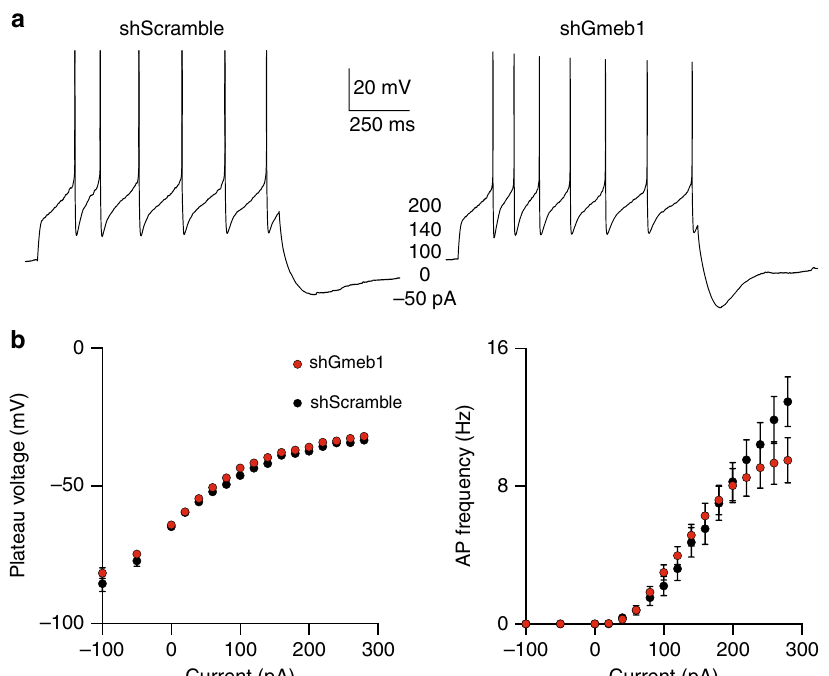
Fig. 4 Gmeb1 knockdown does not impair electrophysiological function in SNc mDA neurons. a Sample current-clamp recordings of action potentials from SNc mDA neurons following injection of depolarizing currents (pA). b Gmeb1 knockdown does not affect the mean plateau voltage or AP frequency of SNc mDA neurons. Shown are the mean (±s.e.m.) plateau voltage (mV) curves (left) and the mean (±s.e.m.) action potential frequency (Hz) (right) of Gmeb1 knockdown ( n = 26 cells) or control ( n = 19 cells) SNc mDA neurons following incremental current (pA) injection